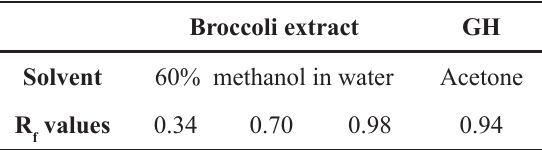
values of broccoli extract and GH by TABLE 1 - R f TLC methods.